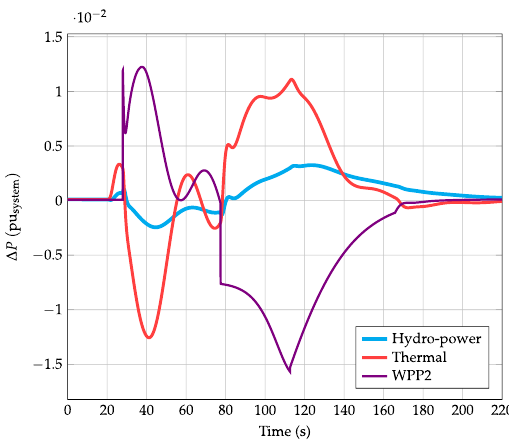
Figure 9. Area 1 under power imbalance ( ∆ P L ,1 ): generation deviations in Area 2.